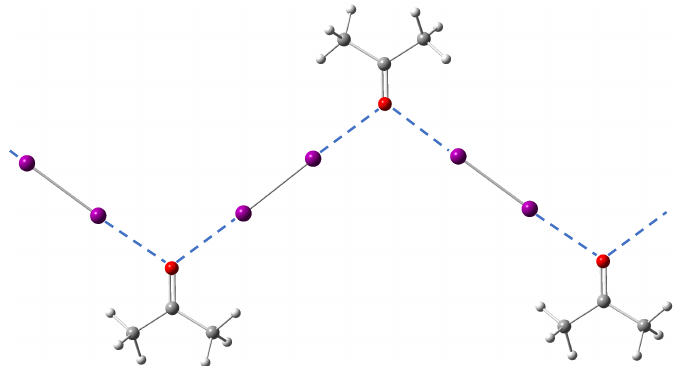
Figure 5. Optimized crystal model structure showing the bifurcated halogen bonding A between diiodine and acceptor molecule A